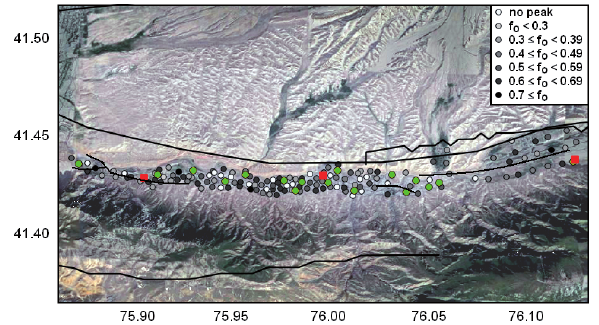
Figure 4. Fundamental frequency at single station measurement sites in Naryn. Temporary network (green dots) installed in summer 2013 and array measurement sites (red dots) are also shown. Black lines represent active faults [Arup and Partners Int. Ltd.